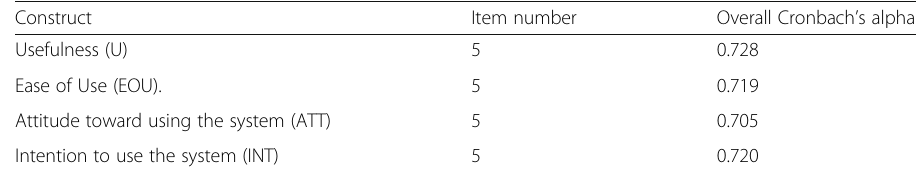
Table 6 Reliability analysis results of the proposed TAM Construct